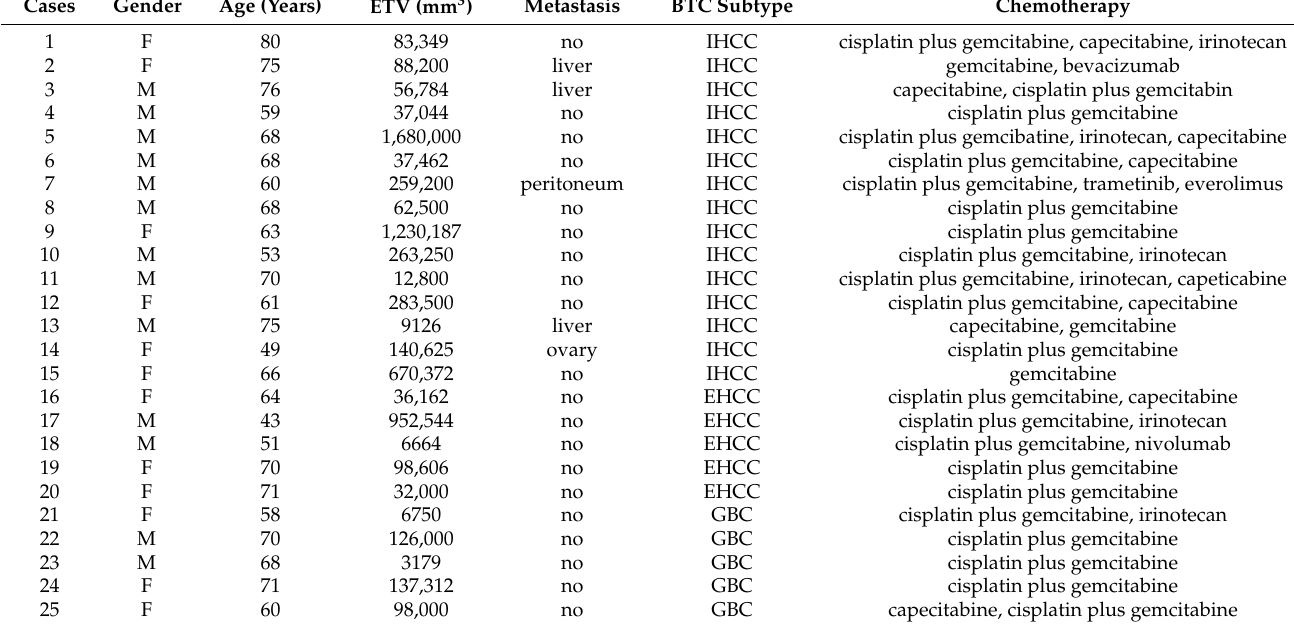
Table 1. Clinicopathological features of the BTC